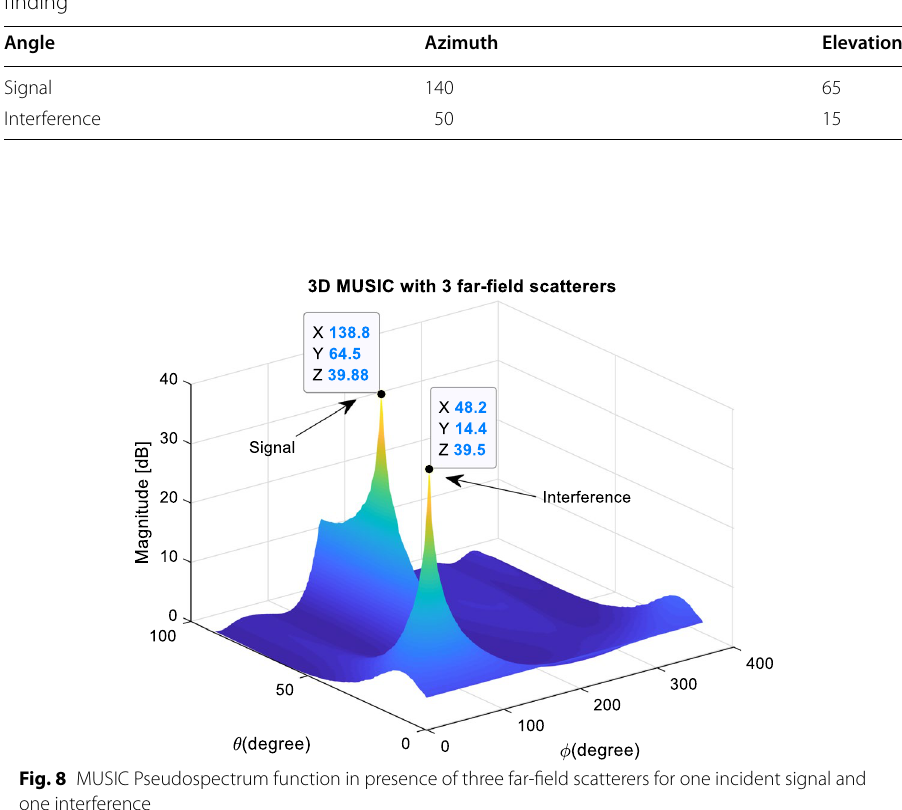
Table 1 The sample azimuth and elevation angles of the signal and the interference for direction